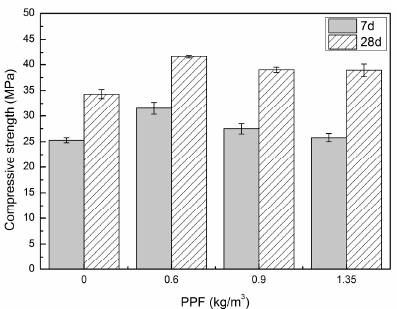
Figure 9. Effect of PPF on compressive strength of concrete.